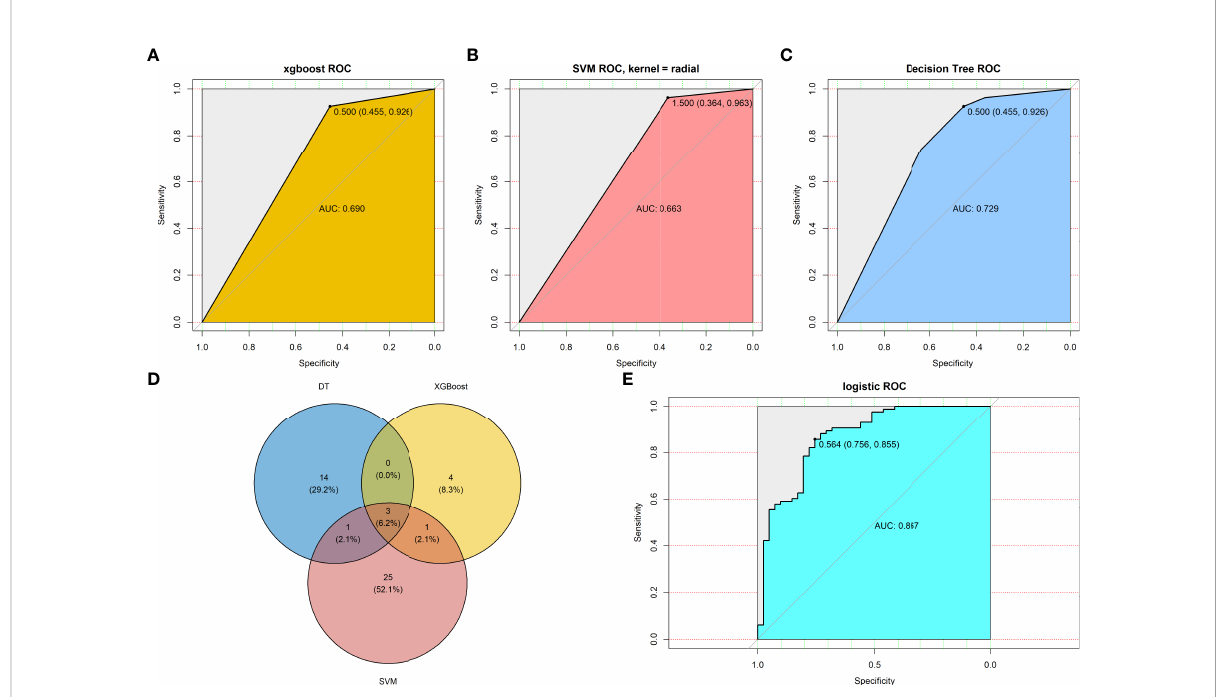
FIGURE 5 Machine learning methods screen key genes response to chemotherapy. Predictive value of TMEscore-relate genes in testing set by (A) XGBoost algorithms; (B) SVM algorithms; (C) DT algorithms; (D) Venn plot revealed three overlapped among the three machine learning methods; (E) Predictive value of the three TMEscore-relate genes signature in the response to chemotherapy by multivariate logistic